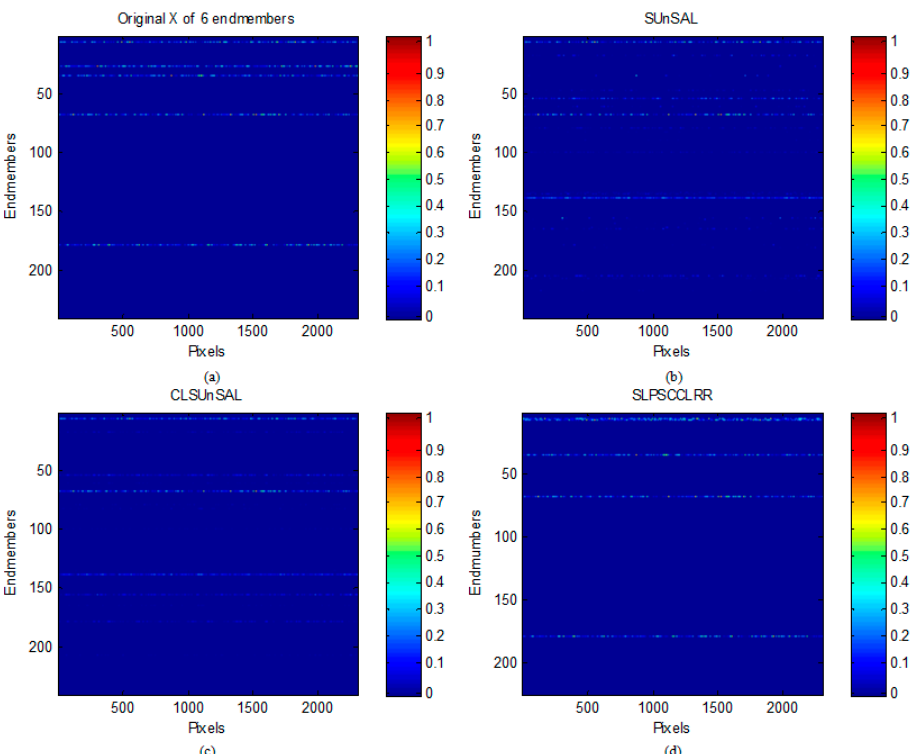
Figure 5. Ground-truth and estimated abundances obtained by different unmixing methods in the scene DC2, with SNR = 40 dB: ( a ) ground-truth abundance; ( b ) estimated abundances obtained by SUnSAL; ( c ) estimated abundances obtained by CLSUnSAL; and ( d ) estimated abundances obtained by SLP-SCC-LRR. Table 3. SRE (dB) and AAD values achieved after applying different unmixing methods to Simulated DATA 2.